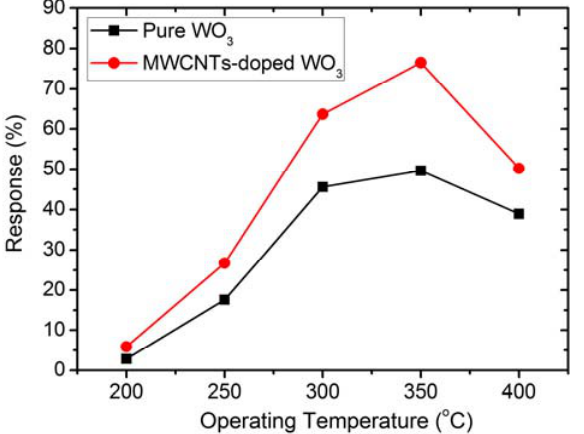
(1,000 ppm) at different operating temperatures. 2